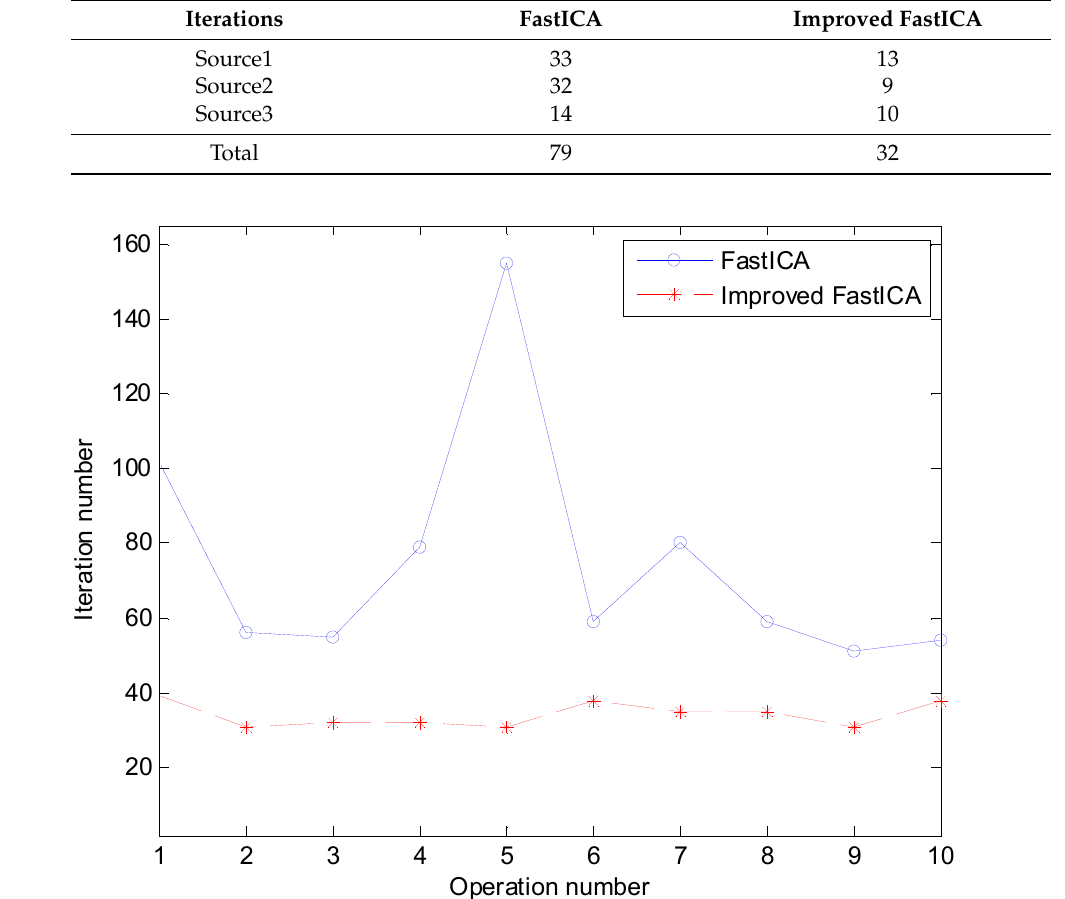
Figure 14. Iteration number under 10 runs using FastICA and improved FastICA.